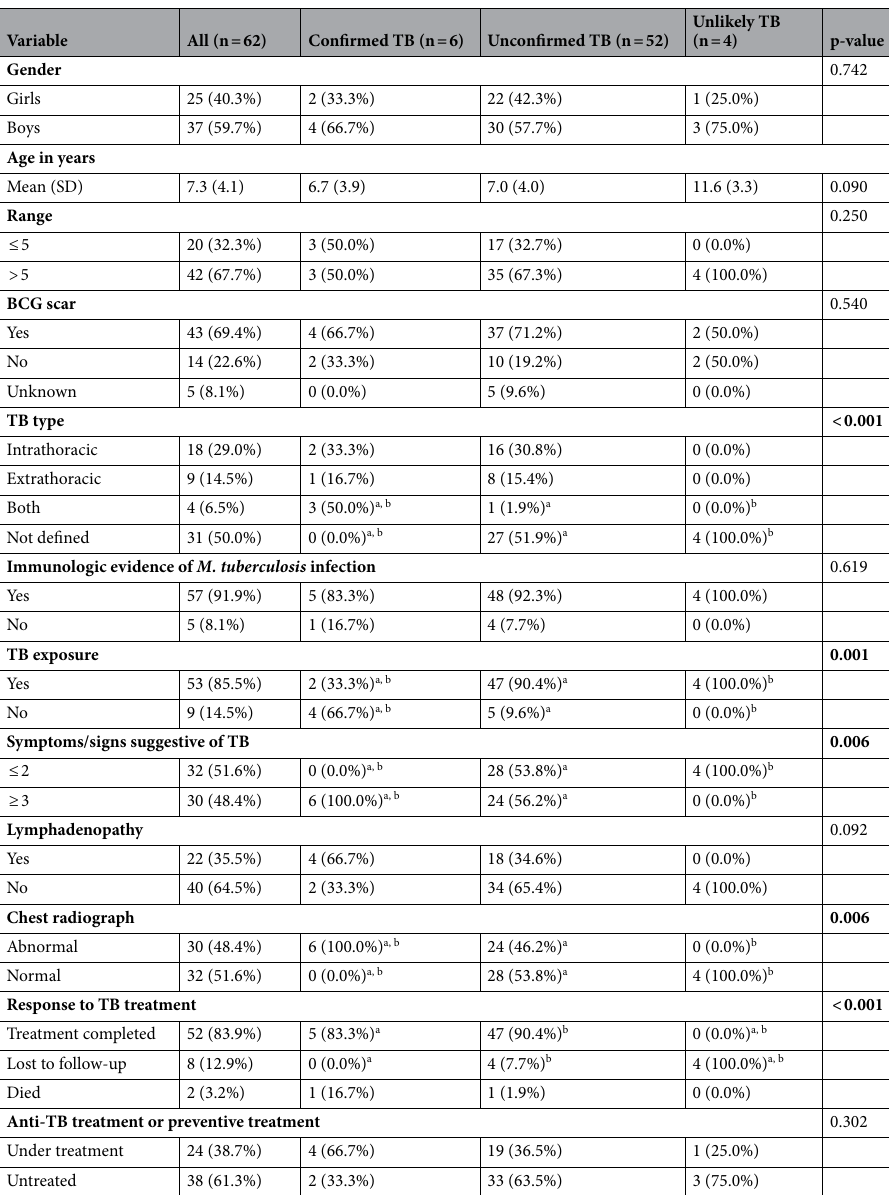
Table 2. Demographic information and clinical criteria of children with presumptive TB. a,b Significant differences in variables when comparing proportions between study groups. If a pair of values is significantly different, the values have the same superscript letters assigned to them. Bold values, significative statistical values with a p-value under 0.05. Categorical variables expressed as number of subjects (n) and percentage (%), and quantitative variables expressed as median and standard deviation (SD). TB tuberculosis, BCG Bacillus